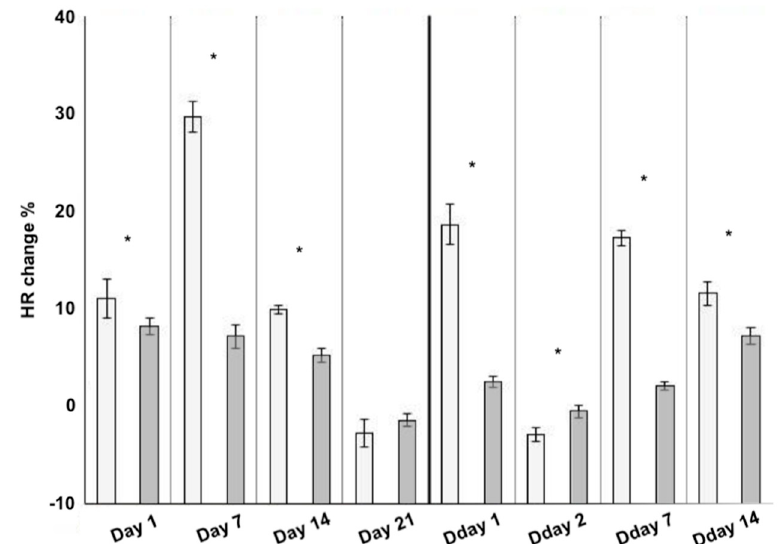
Figure 1. Mean heart rate change in control (light grey) and methamphetamine-exposed (dark grey) signal crayfish (n = 12) pre- and poststress initiation at each sampling day (Day 1–Day 21 days of exposure and Day 1–Day 14 days of depuration). * indicates significant difference ( p < 0.05). Columns correspond to the mean value and whiskers correspond to standard error of mean.